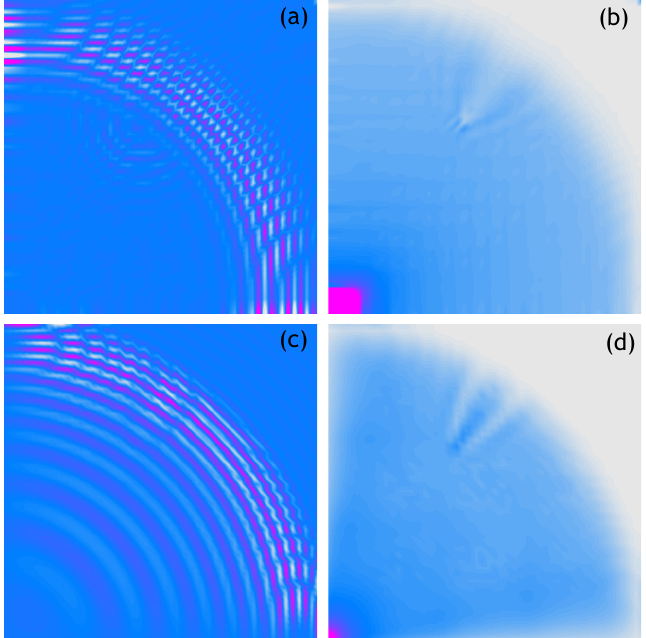
Figure 5. Wave propagation velocity patterns registered at 0.8 ms with 50 × 50 mesh grid, ( a ) Experi- mental data, ( b ) RMS of experimental data, ( c ) Calculated data, ( d ) RMS of calculated